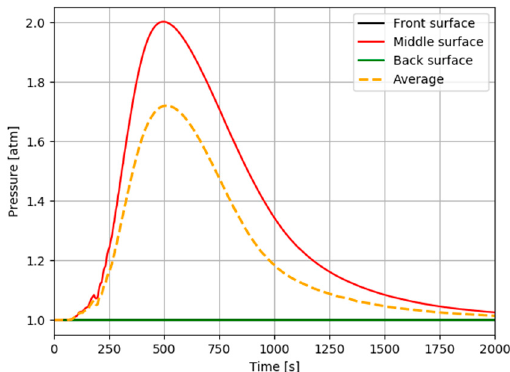
/ vinyl ester material exposed to a heat flux of 50 kW / m 2 ; internal pressure Figure 5. E-glass/vinyl ester material exposed to a heat flux of 50 kW/m 2 ; internal pressure profiles. Figure 5. E-glass